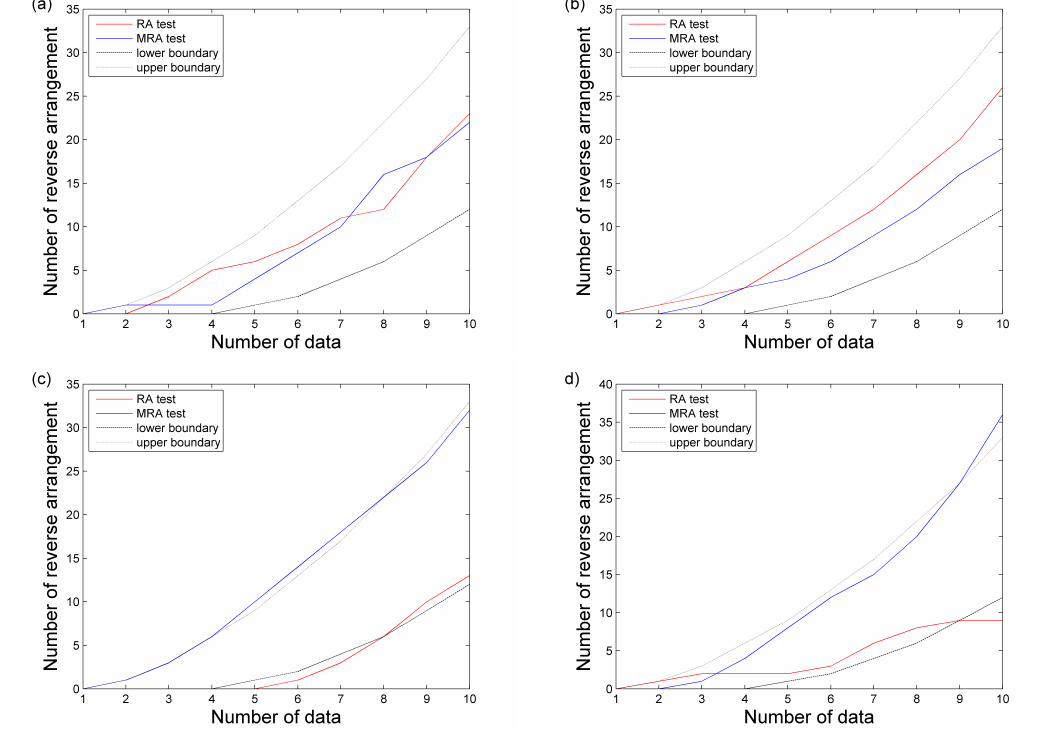
Figure 5. The result of stationarity tests with ( a ) 100 ms; ( b ) 200 ms; ( c ) 500 ms; and ( d ) 1000 ms window size. RA: reverse arrangement; MRA: modified reverse arrangement.